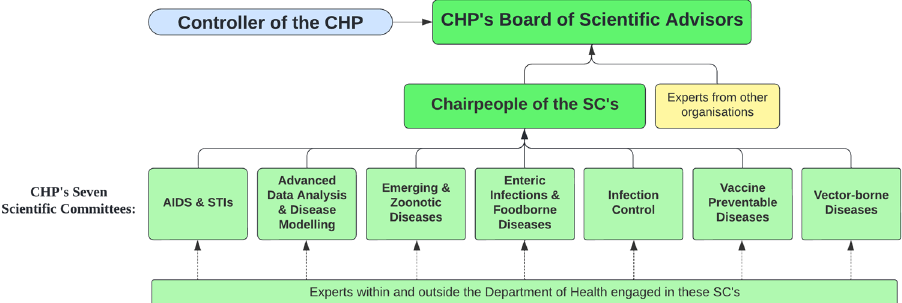
Fig. 4 CHP ’ s seven scienti fi c committees and the reporting hierarchy. The seven scienti fi c committees operate under CHP, and each committee ’ s chair serves as a member on the CHP ’ s Board of Scienti fi